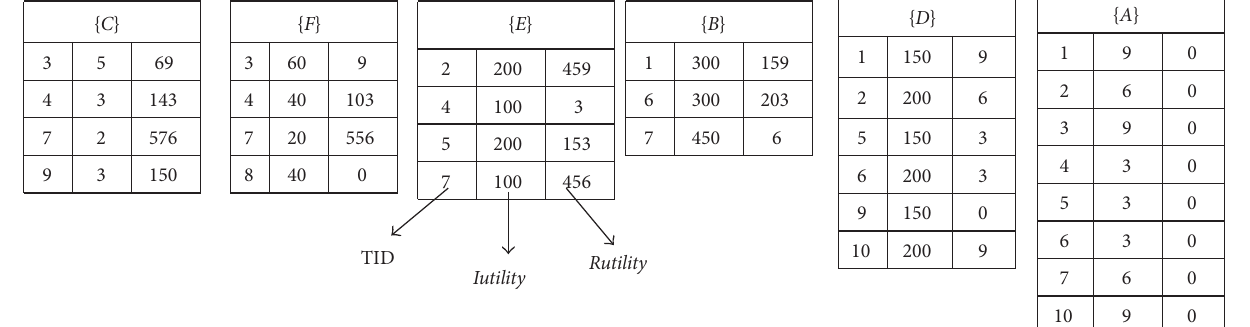
Figure 1: The constructed utility-list structures of 1-itemsets.